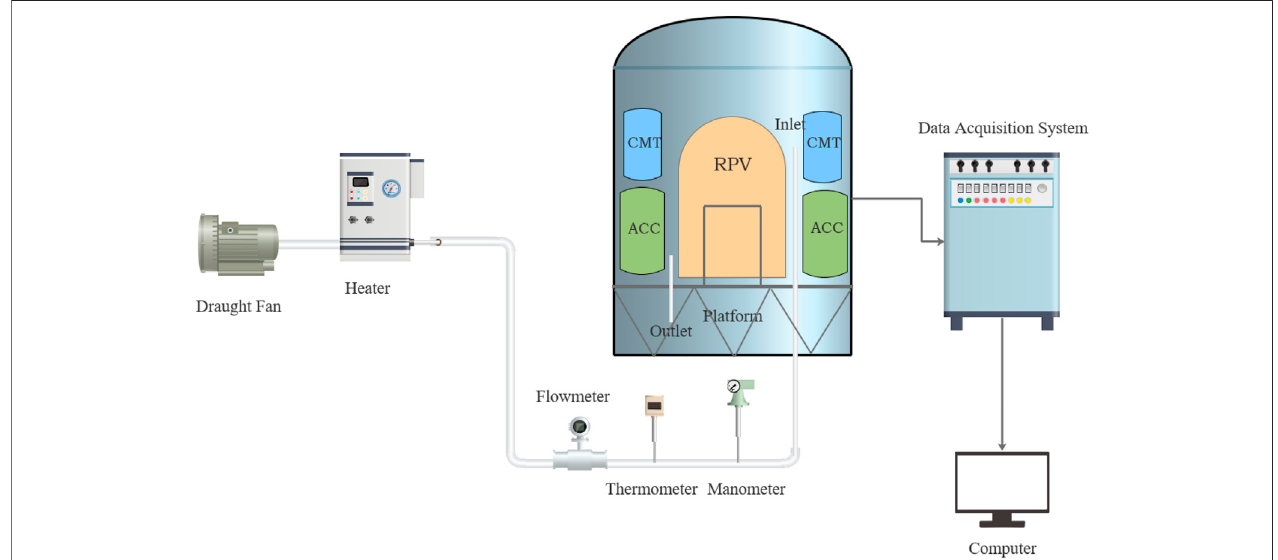
FIGURE 1 | Schematic of the experimental